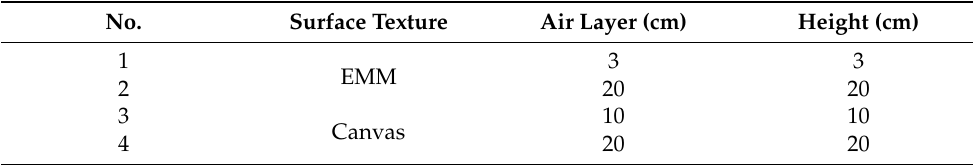
( c ) Specimen of PMRA Figure 2. Composition of specimens. Table 1. Detailed thickness of stage 1 specimens. No.